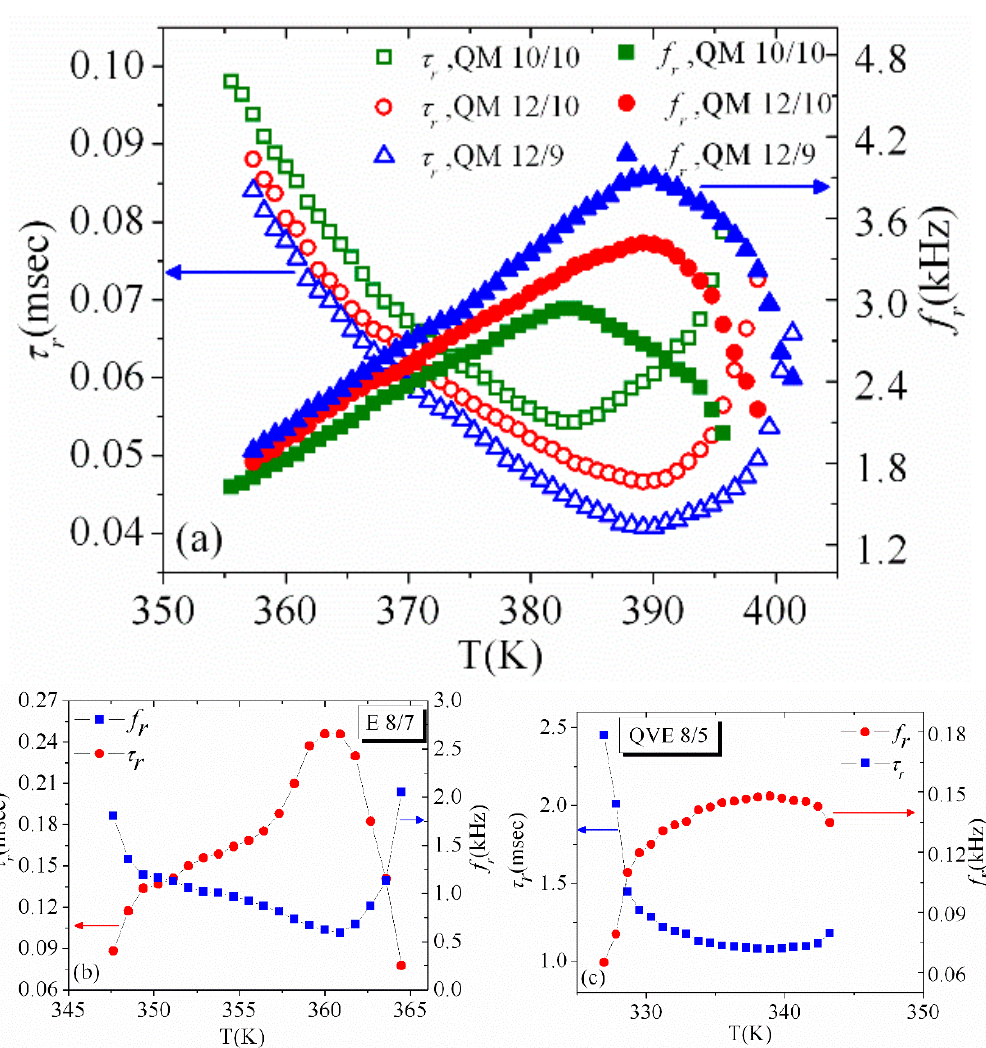
Figure 5. Temperature dependence of the relaxation time and relaxation frequency of the Goldstone mode for: ( a ) three QMn/m compounds as indicated; ( b ) E8/7 compound; ( c ) QVE8/5 compound. The Goldstone mode contributions attributes towards an enhanced relaxation frequency with temperature within the SmC* phase: these values rise, attain a maximum and then starts to decrease about 10K below the N*–SmC* phase transition [54,55], perhaps due to the consequent decrease of ferroelectricity near the SmA*/N*–SmC* phase transitions. Among all three QMn/m compounds, the QM10/10 one exhibits the lowest relaxation frequency that attains its maximum value at the low temperature region in comparison with another two possessing different lengths of chiral and non-chiral terminal alkyl chains. Moreover, the temperature dependence of the relaxation time has an inverse nature in relation to the relaxation frequency [54–56]. Temperature dependence of the relaxation time and relaxation frequency for E8/7 and QVE8/5 compounds are shown in Figure 5b,c, respectively. It may be noted that the temperature dependence of the relaxation frequency in the SmC* phase for QVE8/5 and QMn/m compounds shows a similar trend; however, for E8/7 the behaviour is quite different; first it decreases slightly, then increases with increasing temperature. This anomaly is probably due to an additional polar ester linking group (placed in between the non-chiral alkyl chain and the molecular core), which causes larger dipole moment and their repulsive interaction accounts for increase of relaxation time with increasing temperature. However, the ferroelectric dipolar coupling rapidly diminishes as the N*/SmA*–SmC* phase transition is approached, leading to a consequent decrease of the mutual repulsive interaction which now facilitates quick relaxation process with further increase of temperature. If we compare the values of relaxation frequency ( 𝑓 (cid:3045) ) and relaxation time ( 𝜏 (cid:3045) ) it can be observed that compound belonging to QVEn/m series exhibits larger relaxation time and smaller relaxation frequency due to its relatively high viscosity caused by the presence of the lateral methoxy substitution on the central aromatic ring of the molecular core. Materials from QMn/m series possess smaller relaxation time and larger relaxation frequency due to its more flexible “zigzag shaped” molecular structure. On the other hand, 𝑓 (cid:3045) and 𝜏 (cid:3045) values for materials from En/m series are intermediate with respect to the materials mentioned above. Thus, for the studied ferroelectric liquid crystalline materials, it can be concluded that the parameters of the relaxation mode strongly depend on both the molecular core structure and alkyl chain lengths. 4. Summary of the Results and Conclusion The ferroelectric SmC* phase for the compounds belonging to three structurally different series of chiral self-assembling compounds possessing the ferroelectric polar order has been investigated via broadband dielectric spectroscopy measurements. The behaviour of dielectric spectra not only depends on the temperature but also on the specific molecular structure of the FLC compounds. The results of the investigations lead to the following summary. Within the SmC* phase, both real and imaginary parts of complex permittivity increase upto certain temperature then drop with increasing temperature. The length of the alkyl chains length as well as linkage unit has a great influence on the values of the dielectric permittivities.